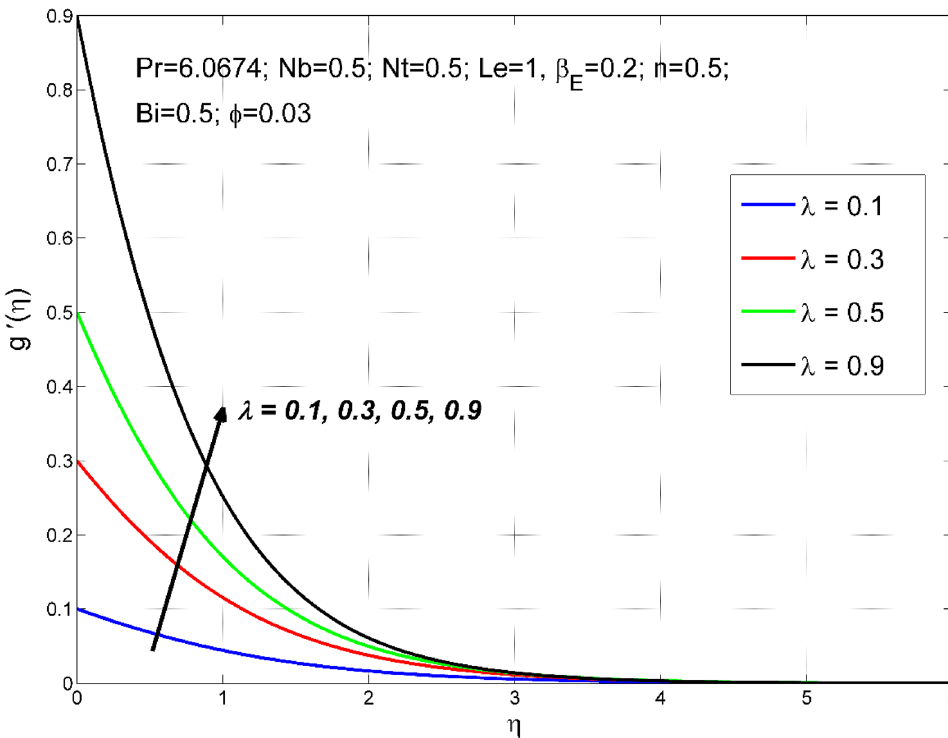
Figure 3. The transverse velocity g ′ (η) behavior for the variation of the stretching ratio (cid:31) .